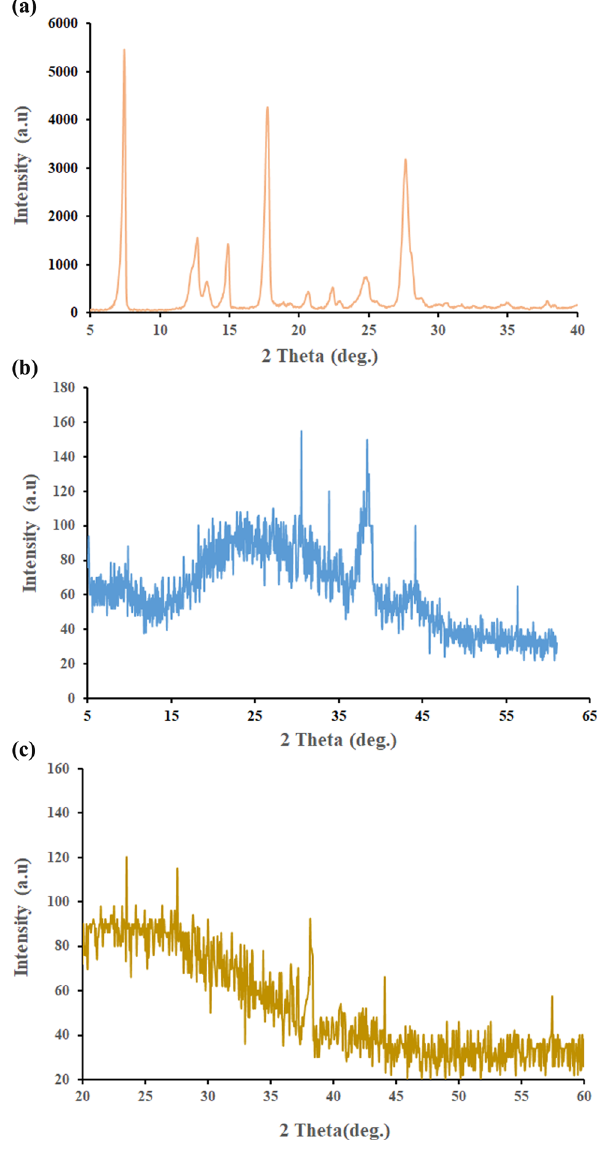
Figure 5: XRD analyses: ( a ) CHR, ( b ) AuNPs, and ( c ) CHR –